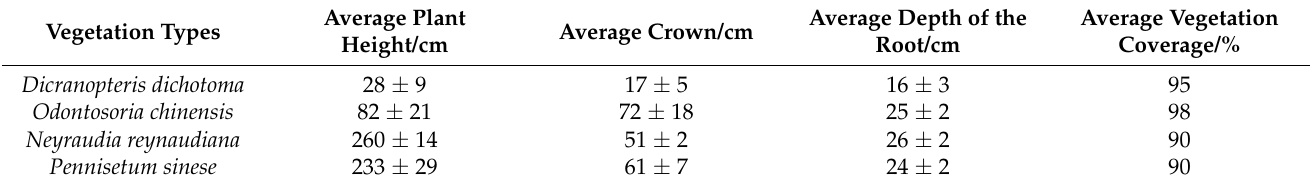
Table 1. Basic situation of vegetation types in the sample plot.